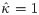
Examples of Cohen’s kappa for 2 spatial variables categorised into 2 groups, illustrating the difficulty in interpretation of kappa with respect to degree of spatial smoothing.The kappa values are a) κ^=1, b) κ^=1, c) κ^=−1, and d) κ^≅0.04.